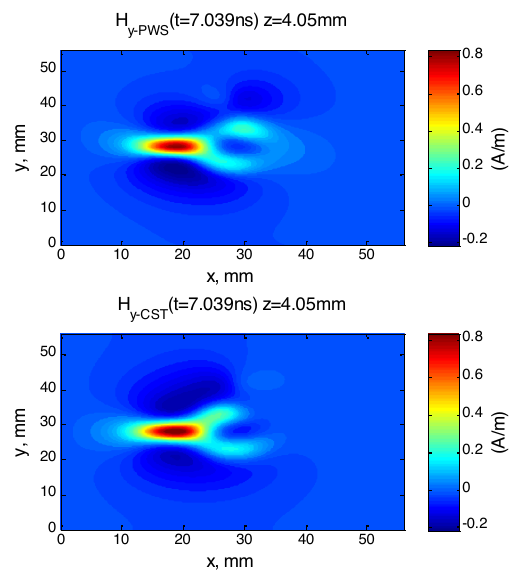
Figure 19: Comparison of H CST simulation and the proposed computation method.